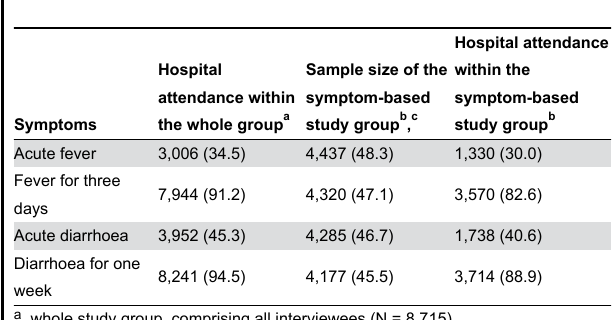
Table 2. Disease symptoms and number of intended hospital visits within the whole group, the study size of the symptom-based study groups, and the intended hospital visits within the constructed symptom-based study groups, Asante Akim North District, Ghana, 2008.